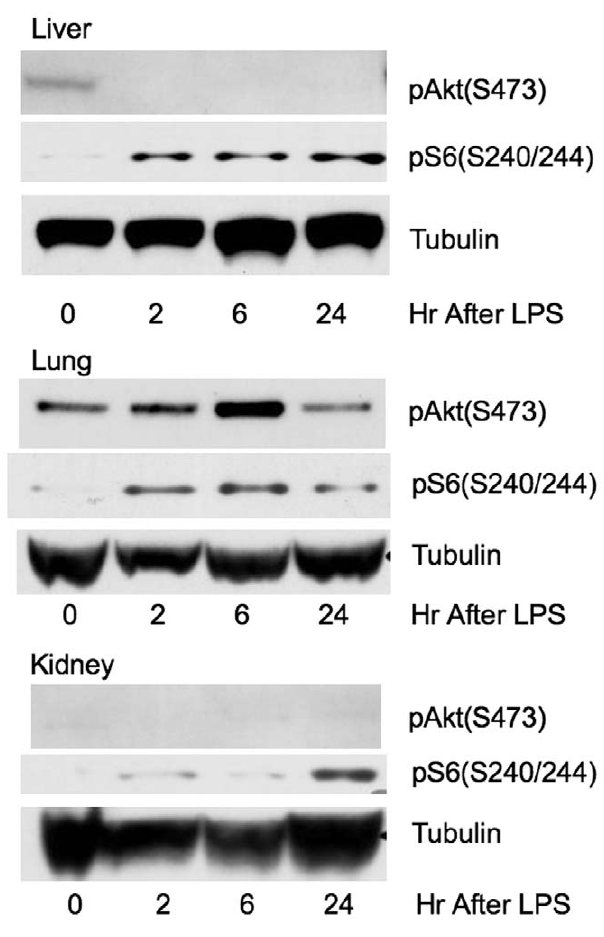
Figure 1. mTORC1-S6K up-regulation in the livers, lungs, and kidneys of mice treated with endotoxin. Representative immuno- blots of normalized organ protein extracts probed for pS6 (S240/244), a downstream target of mTORC1-S6K are shown here. Mice were subjected to 25 mg/kg of LPS i.p. and sacrificed at 2,6, and 24 hr later. Untreated mice served as time 0 hr controls. mTORC1-S6K activation could be seen as early as 2 hr after LPS challenge in the livers and lungs of endotoxemic mice. mTORC1-S6K was also activated in the kidneys at 24 hr post challenge. Increased pAkt (S473) was seen only in the lung extracts post LPS challenged, occurring at 6 hr post LPS, after